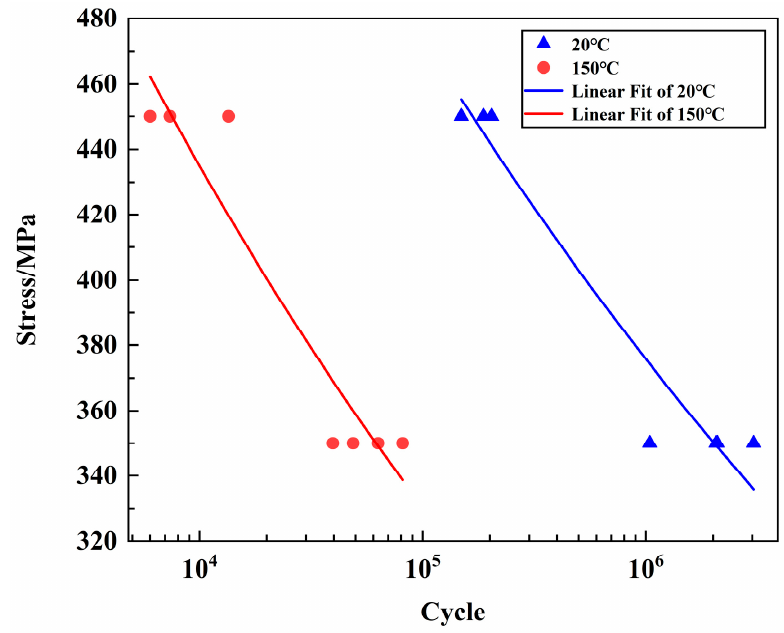
Figure 22. Standard fatigue specimen life curve.